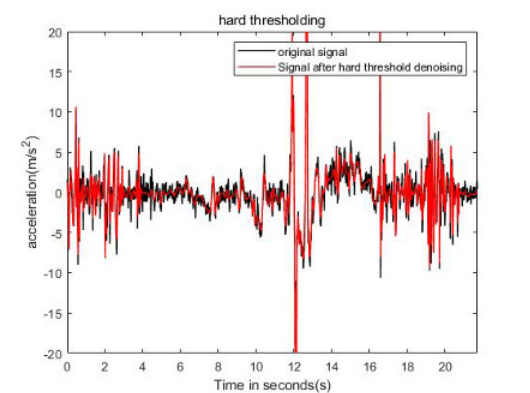
Fig. 2. Figure with signal data processed by hard threshold function.